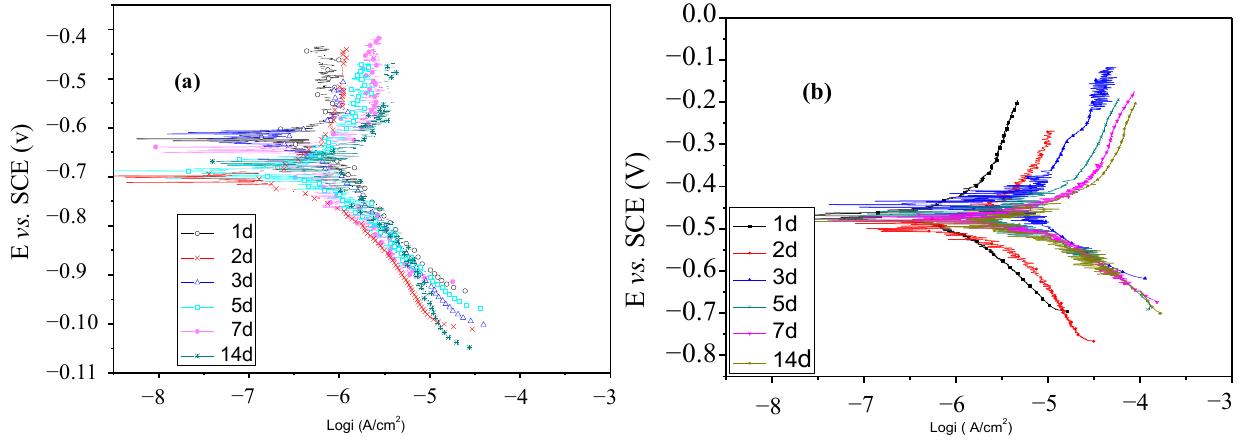
Figure 7. Polarization curves of titanium immersed in artificial saliva without ( a ) and with 5.0 g/L lactic acid ( b ) for different immersion